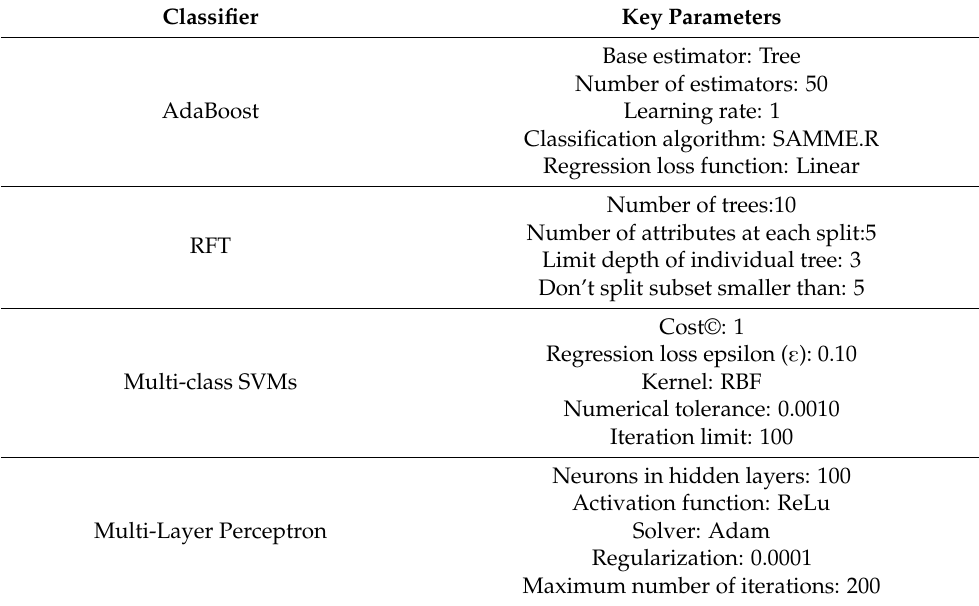
Table 3. Key parameters of four